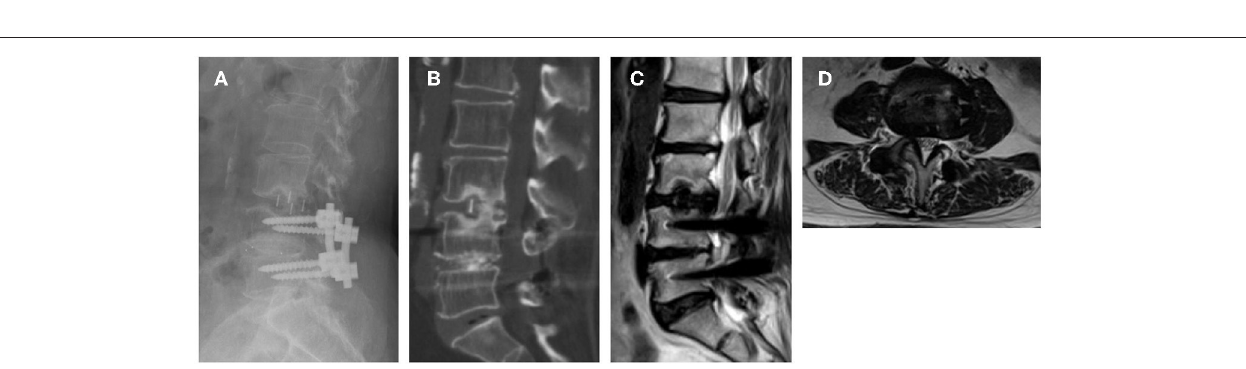
FIGURE 2 | Images obtained in the same patient. Disk height (A,D) , foraminal height (B,E) , and foraminal CSA (C,F) were evaluated with CT before and at last follow-up after surgery. (A–C) are before surgery, and (D–F) are at last follow-up after surgery.